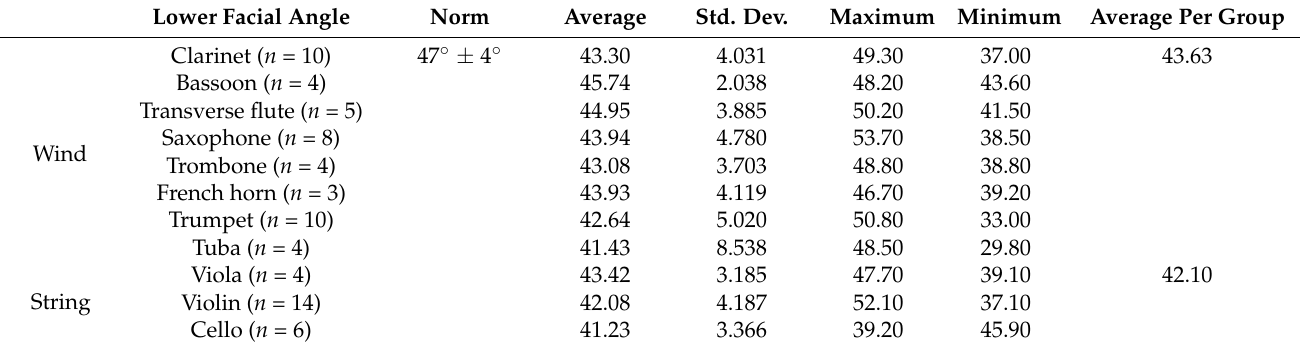
Table 4. Descriptive statistics for the variable lower facial angle.